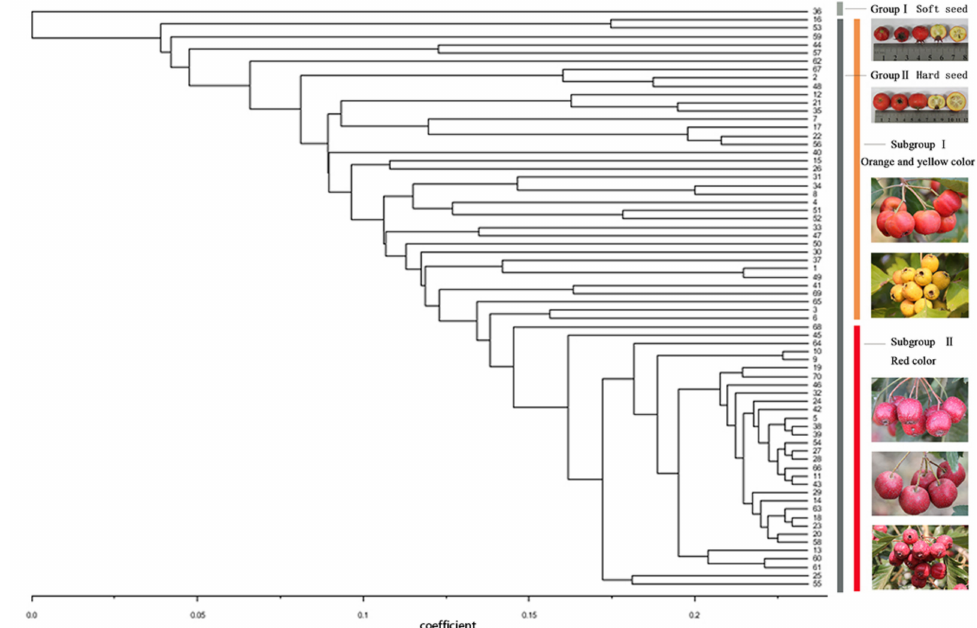
Figure 4. A UPGMA dendrogram of 70 hawthorn cultivars based on 33 EST-SSRs. The numbers on x -axis were genetic similarities represented by coefficient